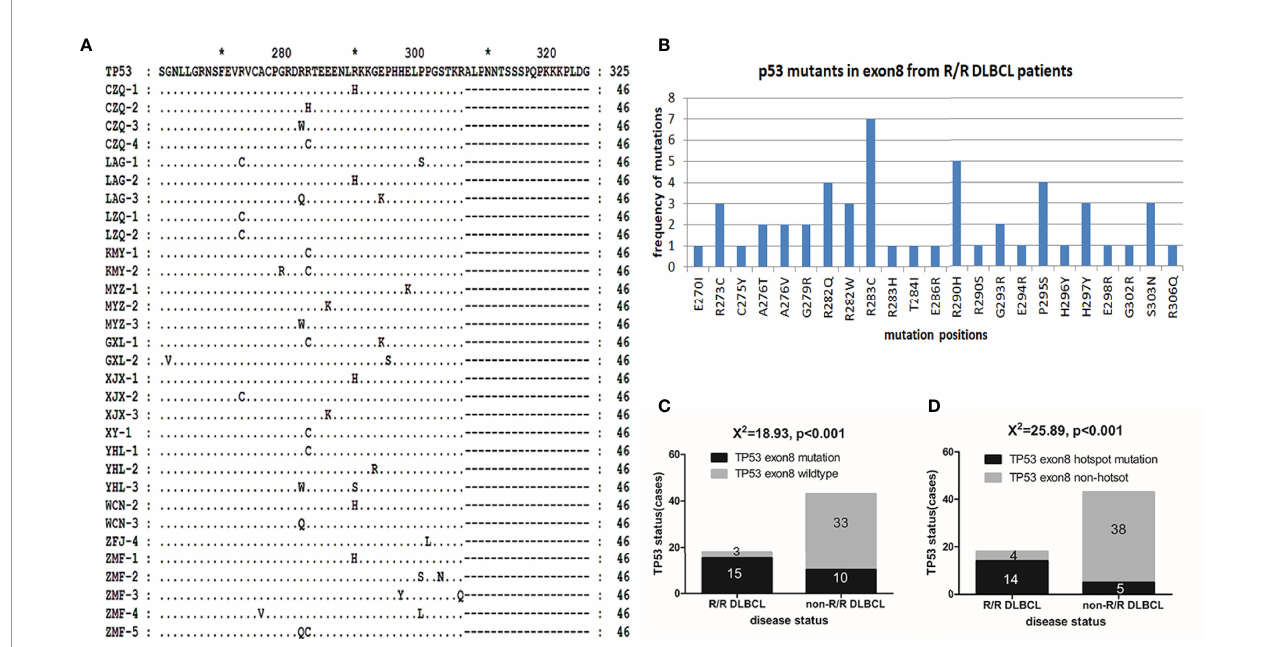
FIGURE 2 | p53 mutants in R/R DLBCL. (A) p53 mutants were detected in R/R DLBCL. p53 protein sequences were translated with the Genedoc software based on DNA sequences and aligned with the Clustal and Genedoc software. (B) Distribution of p53 point mutants in R/R DLBCL. Numbers are the total number of patients in which a mutation was detected. (C, D) TP53 mutation rates in R/R and non-R/R DLBCL. Frequencies were calculated as a percentage. Differences between groups of patients were assessed with the maximum likelihood chi-squared test.